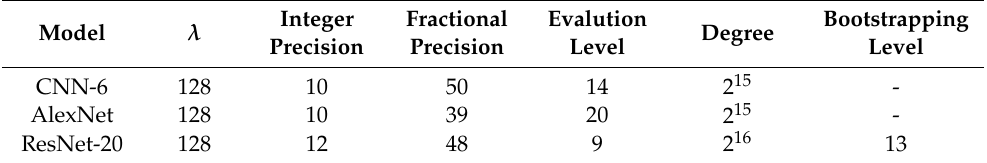
Table 2. Safety parameters